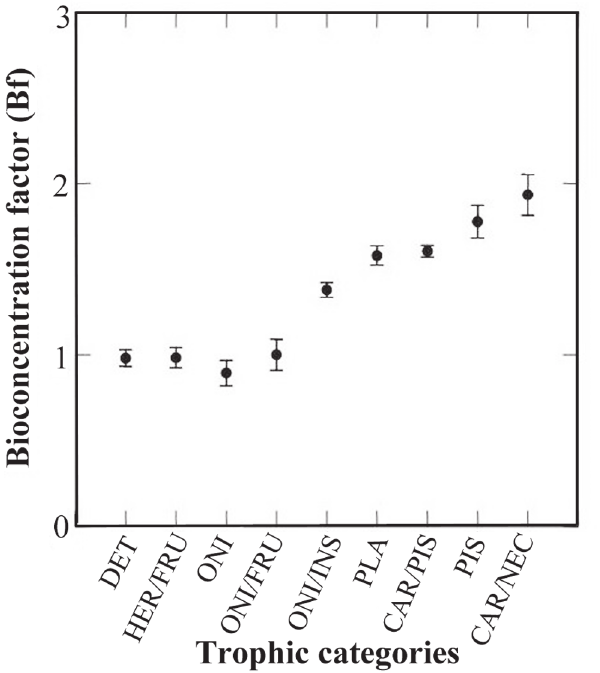
Fig. 3. Bioconcentration factor (Bf) among trophic categories in the Lago Grande de Manacapuru, in the Amazon floodplain. DET, Detritivores; HER/FRU, Herbivores/Frugivores; ONI, Omnivores; ONI/FRU, Omnivores/Frugivores; ONI/INS, Omnivores/Insectivores; PLA, Planktivores; CAR/PIS, Carnivores/Piscivores; PIS, Piscivores; CAR/NEC,